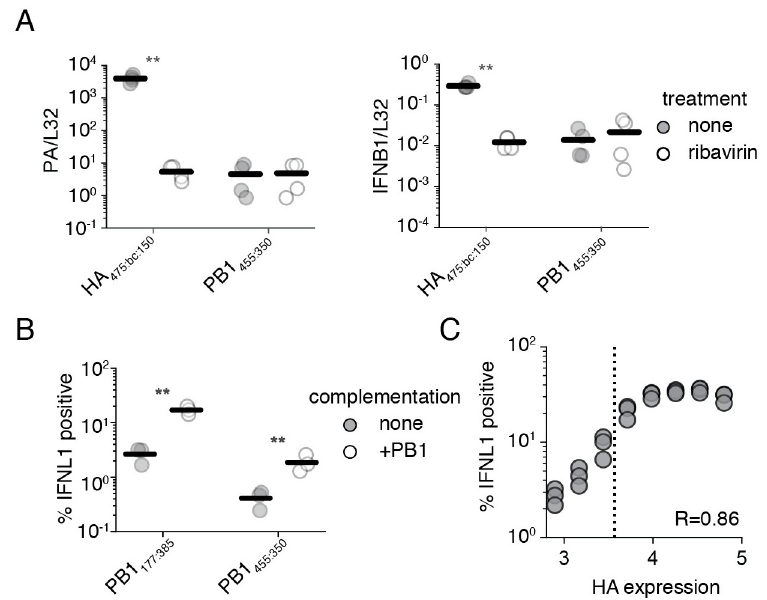
Fig 6. Genome replication is a key component of interferon induction. (A) (left) qPCR against PA , as corrected by the housekeeping gene L32 , was used to validate the suppression of viral replication by the antiviral nucleoside ribavirin. (right) qPCR against IFNB1 as corrected by the housekeeping gene L32 demonstrates the suppression of interferon induction by a deletion capable of genome replication. A549 cells were pretreated with 200 μ M ribavirin for 2h and then infected at an MOI of 0.5. RNA was harvested for analysis after 14 hours of infection. Astrisks indicate strains wherein signal was significantly impacted by treatment. Two-tailed t-test. n = 4. Similar data with neuraminidase shown in S15 Fig. (B) Complementation of PB1 defective species by PB1 expression in trans increases interferon induction. The fraction of cells in a population expressing a type III interferon reporter when infected with the indicated influenza variant at an MOI of 0.5 for 13h. Gating schema shown in S16 Fig. (C) The increase in interferon-induction observed in (B) is linked to influenza replication. Complemented cells were infected as in (B) with an MOI of 0.5 of PB1 177:385 , stained for the viral protein HA and analyzed after 13h. Points represent binned values of HA expression, each point represents the right-most edge of a bin. The dotted line is the 99 th percentile of PB1 177:385 HA staining without complementation. R represents the Spearman correlation coefficient. n = 3. Gating schema shown in S17 Fig. For panels (A) , and (B) , individual points are individual measurements, lines are mean values. For panels (A) , and (B) significance was calculated using Benjamini-Hochberg correction at an FDR of 0.05.